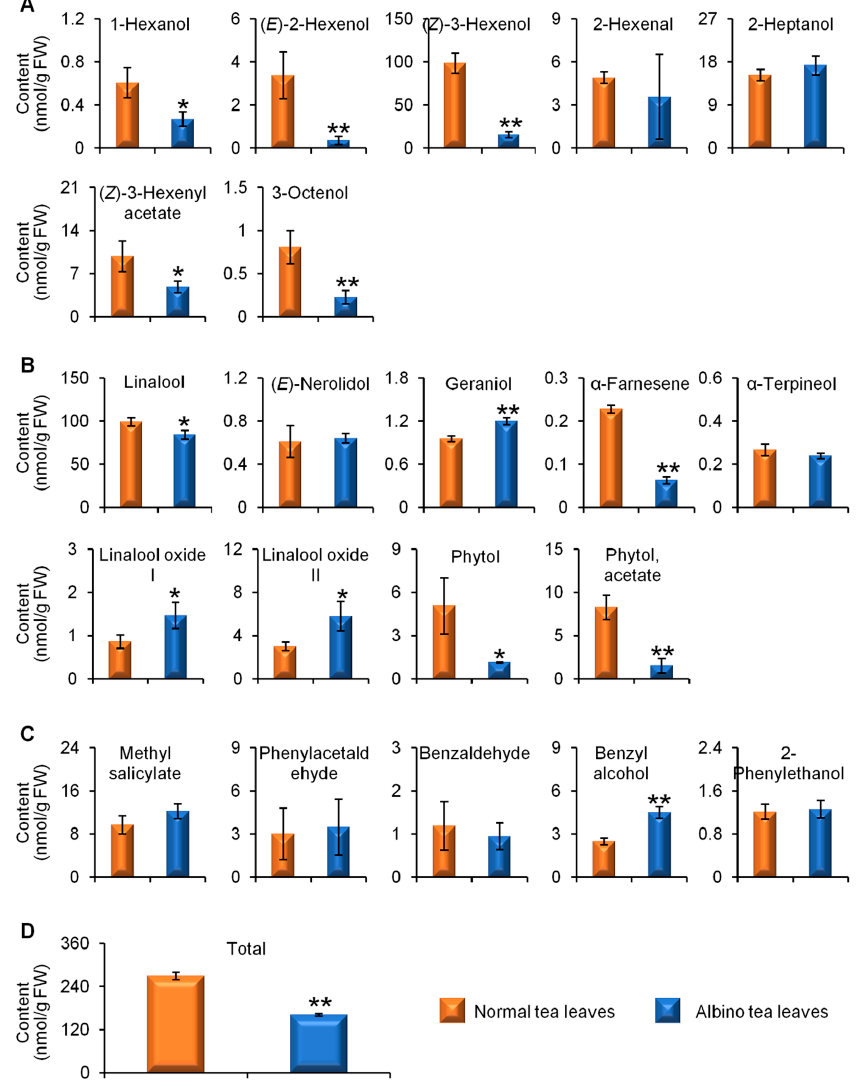
Figure 1. Differential accumulation of endogenous free aroma compounds in normal green and albino-induced yellow tea ( Camellia sinensis ) leaves (cv. Yinghong No. 9) collected in April. ( A ) aroma fatty acid derivatives; ( B ) aroma terpenes; ( C ) aroma phenylpropanoids/benzenoids; ( D ) total content of aroma compounds shown in ( A – C ). The identification and quantitative analysis of the aroma compounds is summarized in Table S1 (Supplementary Information). All data are expressed as mean ± S.D. ( n = 3). Significant differences between normal and albino tea leaves are indicated (* p ≤ 0.05, and ** p ≤ 0.01). FW, fresh